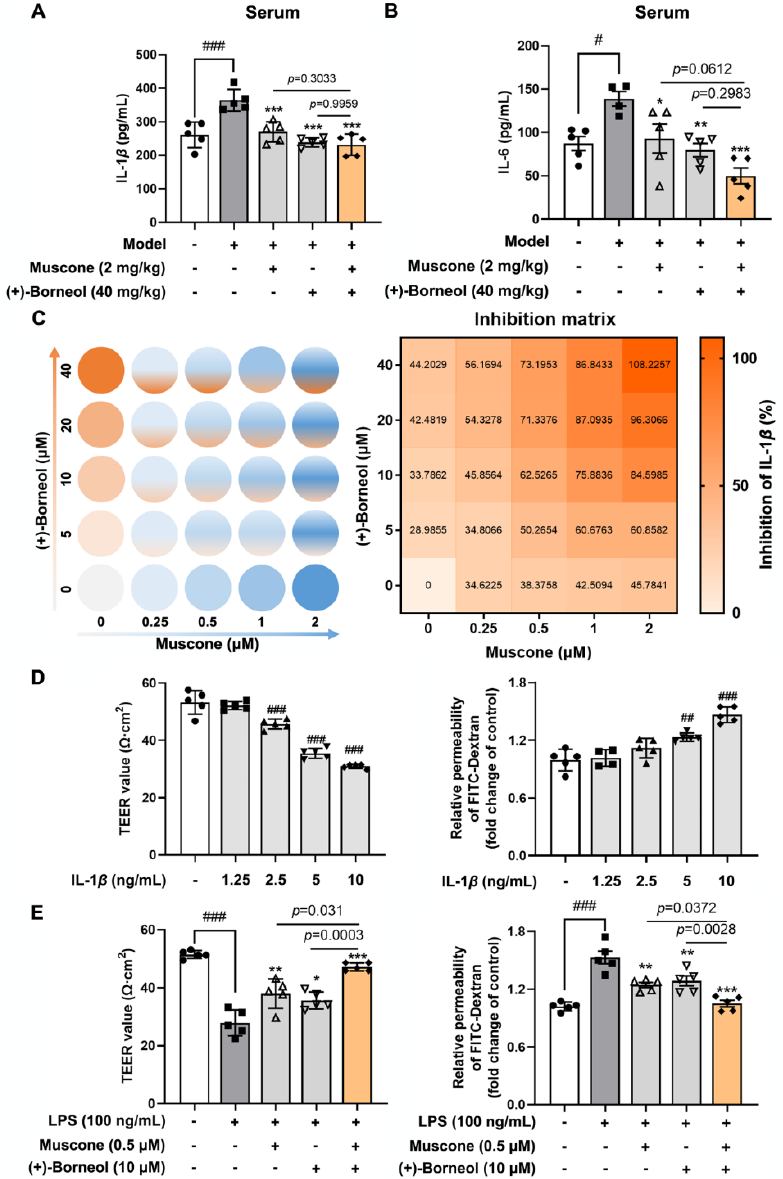
Figure 2. Muscone and (+)-borneol protect endothelial function by reducing IL-1 β release. ( A , B ) the levels of IL-1 β and IL-6 in the serum of mice treated with photothrombotic stroke were detected by Elisa kit ( n = 5); ( C ) the inhibition matrix of IL-1 β production in LPS-induced bEnd.3 cells treated with muscone (dose range from 0 to 2 μM) and (+)-borneol (dose range from 0 to 40 μM) for 16 h; ( D , E ) relative transepithelial electrical resistance (TEER) value and FITC-dextran (70 kDa) permeability of bEnd.3 monolayers cultured in a 0.4 μm Transwell membrane were measured when exposed to IL-1 β insult. Data are presented as mean ± SD ( n = 5). * p < 0.05, ** p < 0.01, *** p < 0.001 vs. Model or LPS treatment; # p < 0.05, ## p < 0.01, ### p < 0.001 vs. indicated treatment or untreated group. p values are determined by one-way ANOVA followed by Tukey’s test.